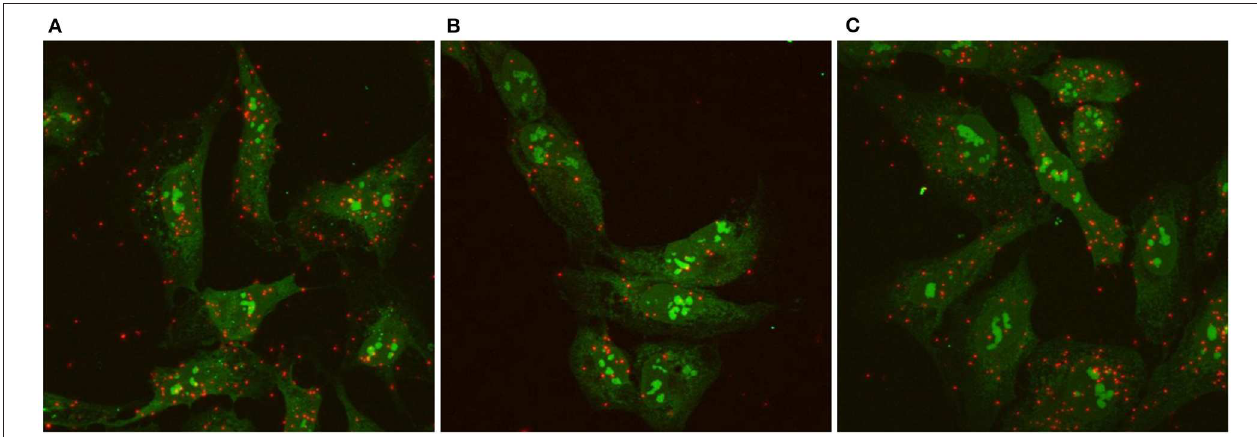
FIGURE 4 | TSHR/IGF1R crosstalk is dependent on receptor proximity and β -arrestin 1 stabilizes the protein complex. TSHR/IGF1R signaling complexes were detected using a Proximity Ligation Assay (PLA) and visualized with fluorescent microscopy. A PLA signal is measured when TSHR and IGF1R are in a protein complex within 40nm of each other. PLA was performed in unstimulated U2OS-TSHR cells treated with non-targeting (A) , β -arrestin 1 (ARRB1) (B) , or β -arrestin 2 (ARRB2) (C) siRNA. Positive PLA signals are shown in red. SYTO9 nucleic acid staining, applied to determine the cell number, is shown in green at × 63 magnification. The knock-down of β -arrestin 1 reduced the number of positive PLA signals by 55% demonstrating this proteins stabilizing function in the TSHR/IGF1R complex (52).